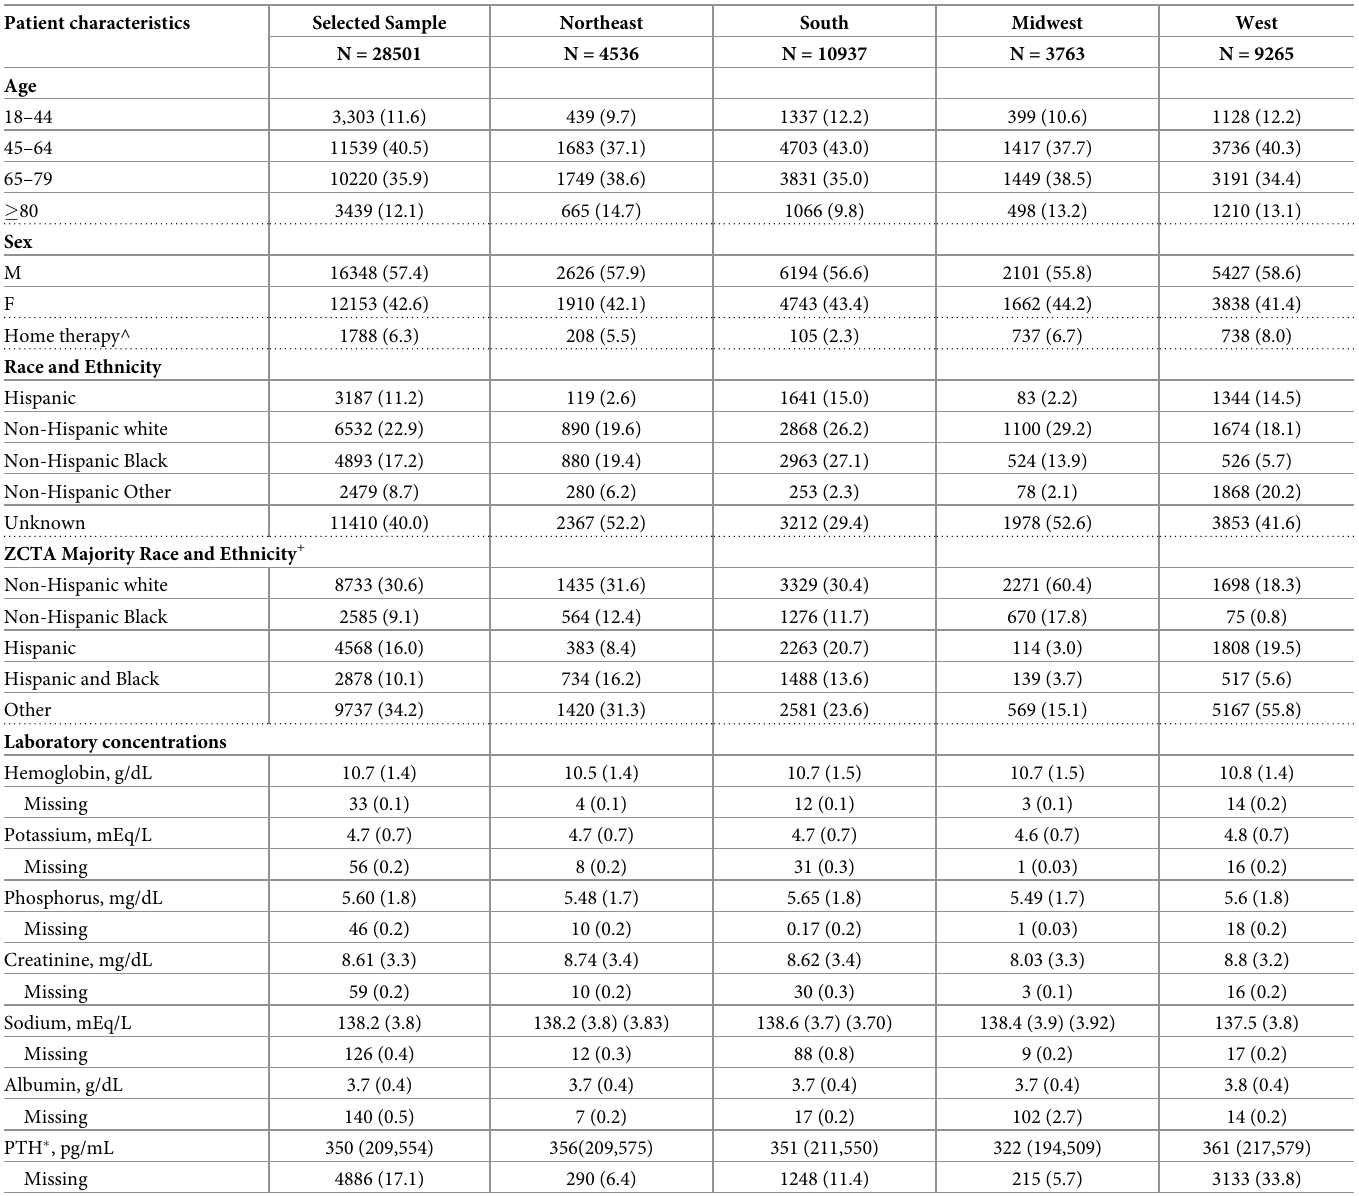
Table 1. Sampled patient characteristics by